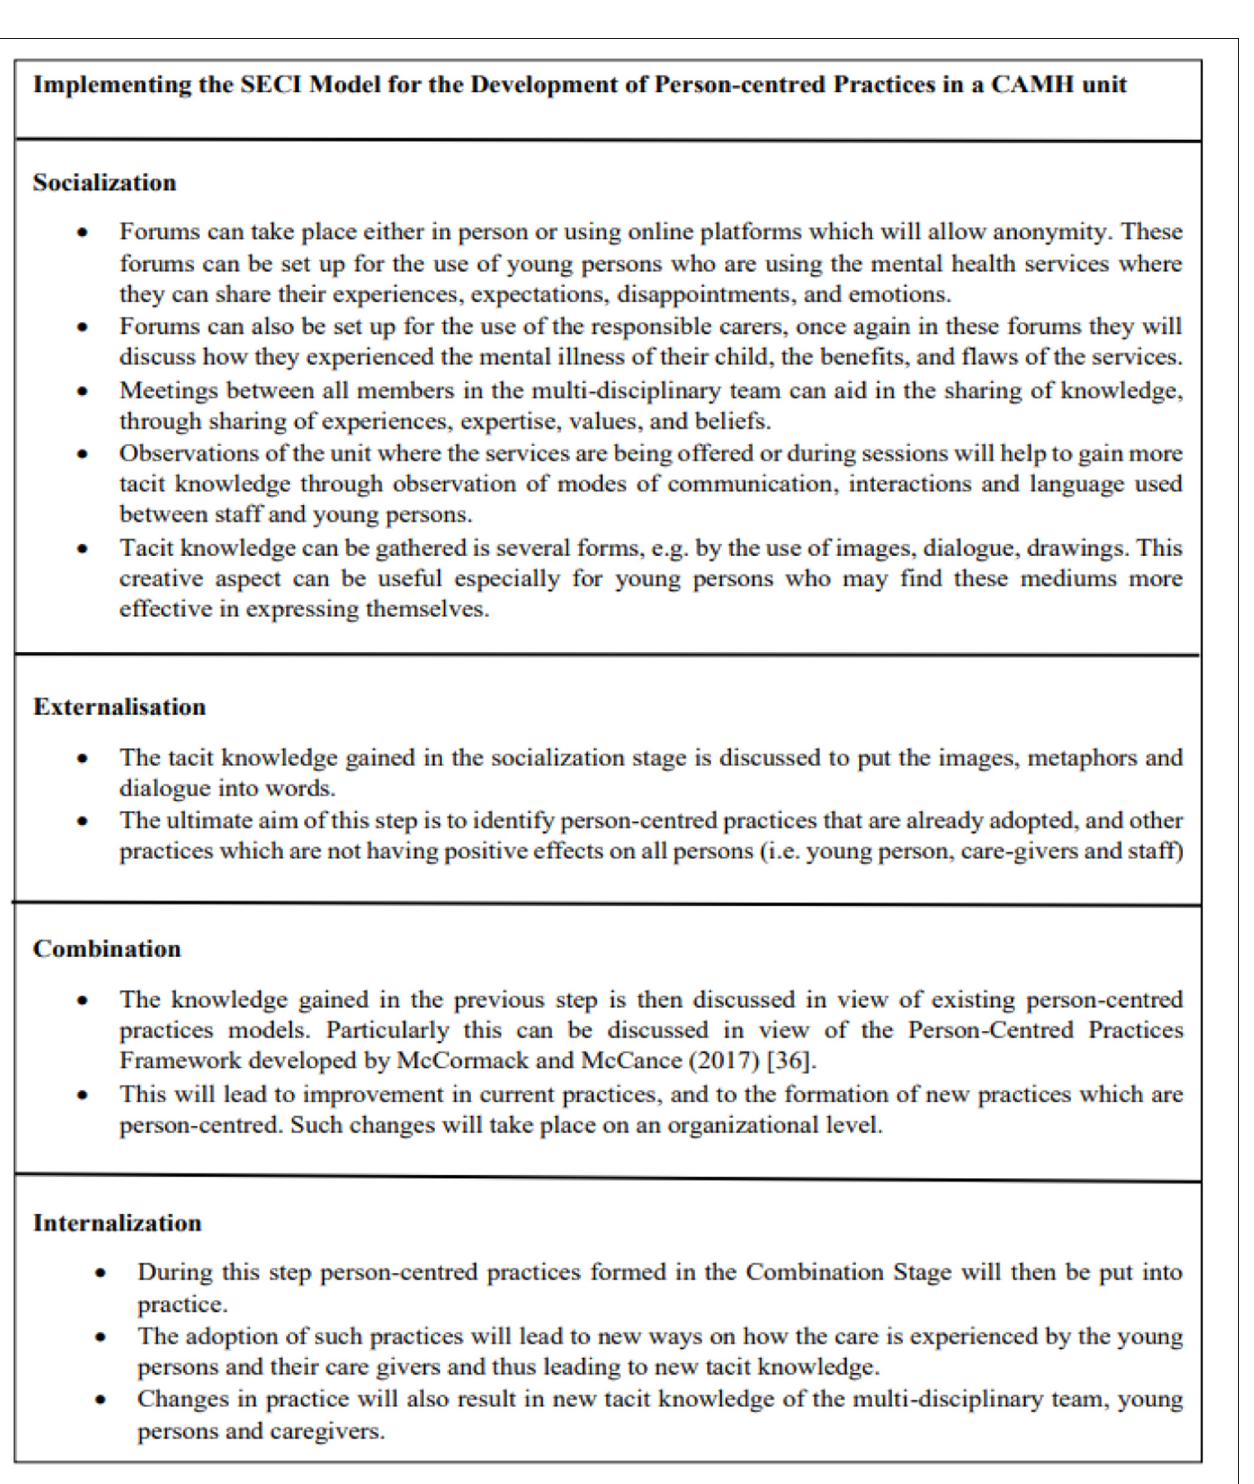
FIGURE 1 | Application of the SECI model in the development of person-centered practices in a CAMH unit.